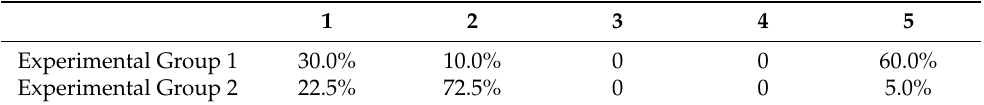
Table 4. The selection rates of each experimental